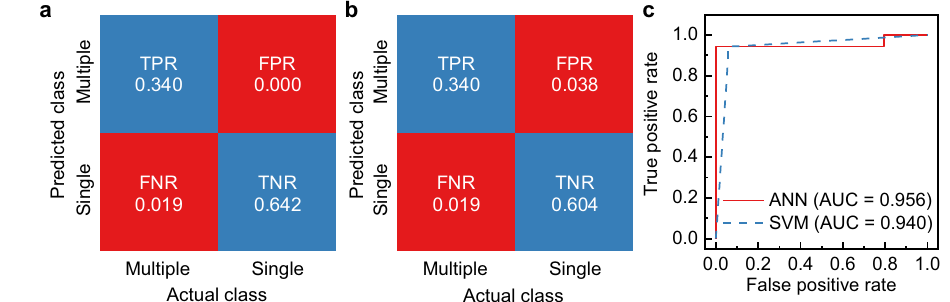
Fig. 3 Performance of ML models. Confusion matrix of a ANN and b SVM models. c ROC curves and AUC scores of ANN and SVM models. TPR, FPR, FNR, and TNR refer to the true positive rate, false positive rate, false negative rate, and true negative rate,